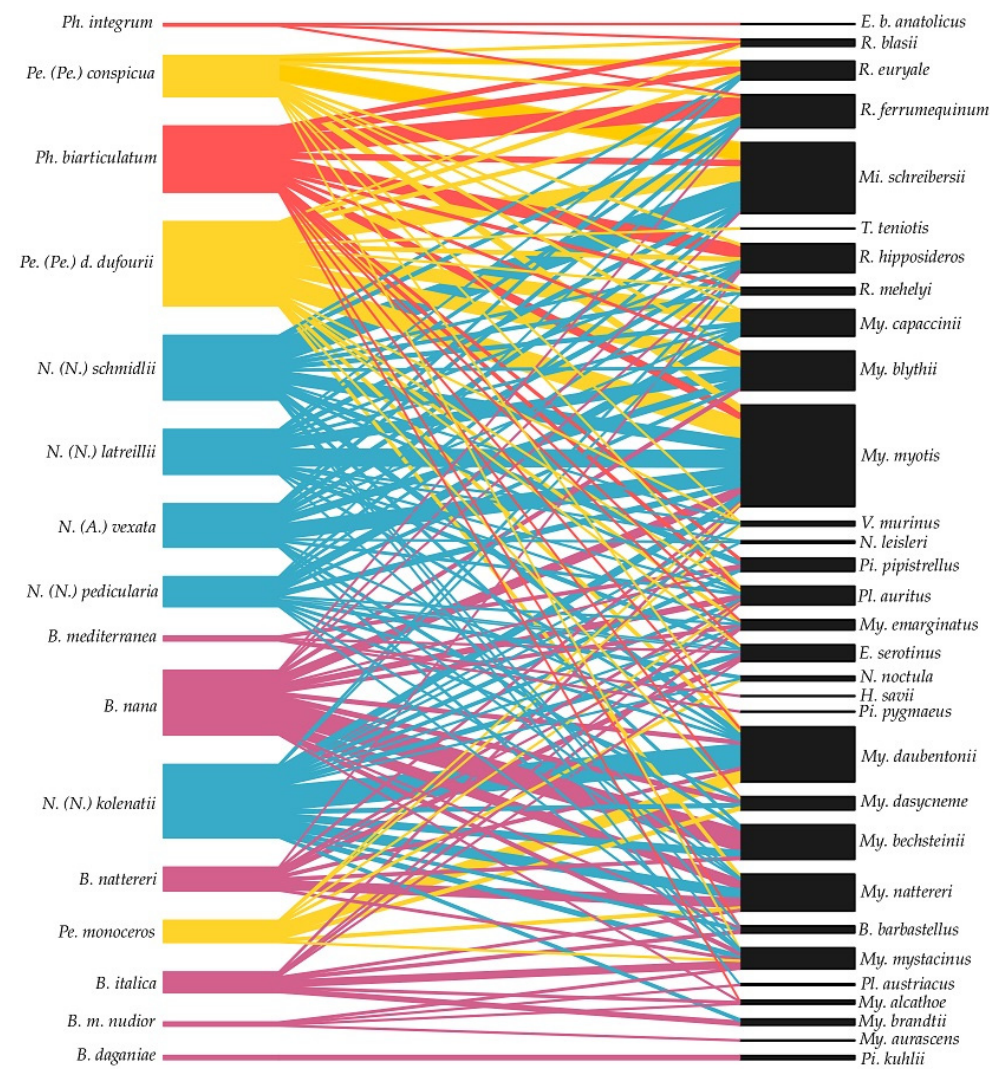
Figure 6. Bipartite network graph of interactions between bat flies (left) and bats (right). Each color of bat fly species means one genus ( Basilia —purple, Nycteribia —blue, Penicillidia —yellow, and Phthiridium —red. The overlap of lines is minimized and parasite species are ordered so that the closest are those that have the most common hosts, and on the other hand, the parasites are ordered by similarity in terms of common hosts.